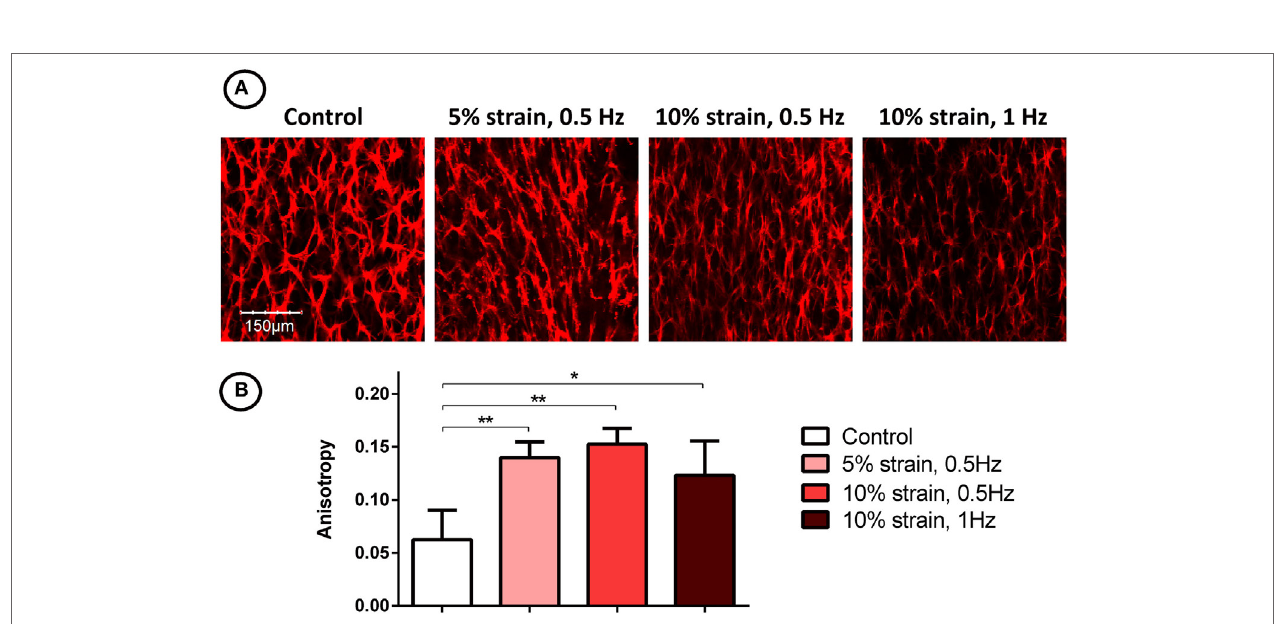
FigUre 5 | F-actin staining (a) and quantification of filament anisotropy (B) of multipotent stromal cells encapsulated in fibrin hydrogels and cultured in tensile strain bioreactors in media supplemented with chondrogenic growth factor transforming growth factor- β 3 for 21 days. The application of cyclic tensile strain was found to increase cellular organization. Significant differences are indicated where present (* p < 0.05; ** p < 0.01; n =